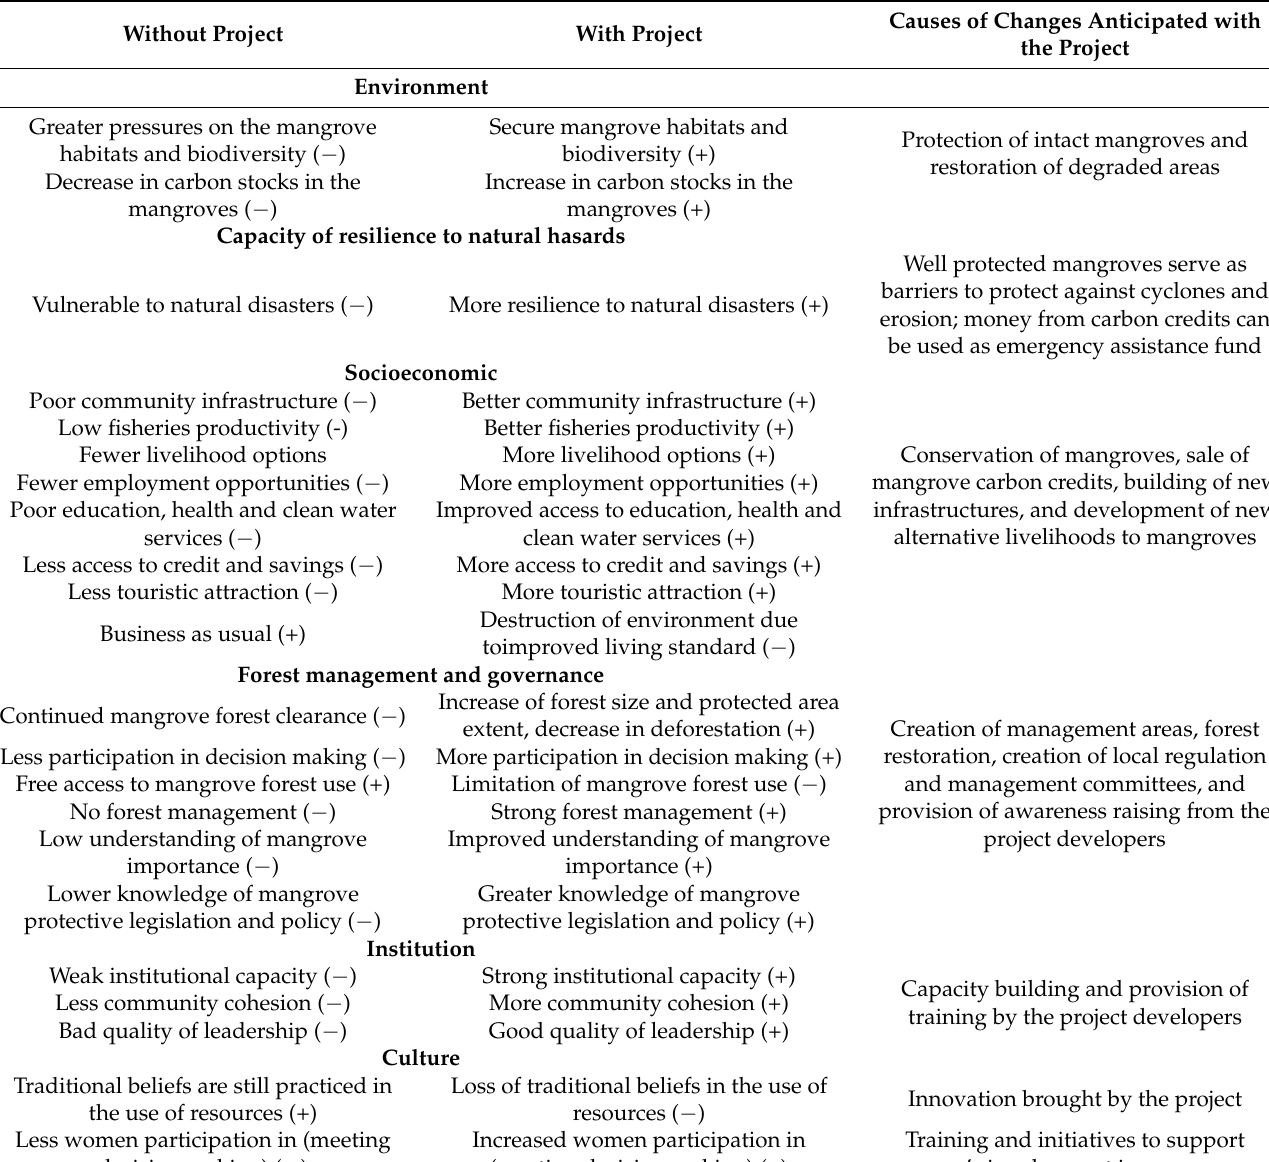
Table 5. Perceived changes in the Baie des Assassin’s conditions with and without the PES project. (+) represents positive changes and ( − ) for negative